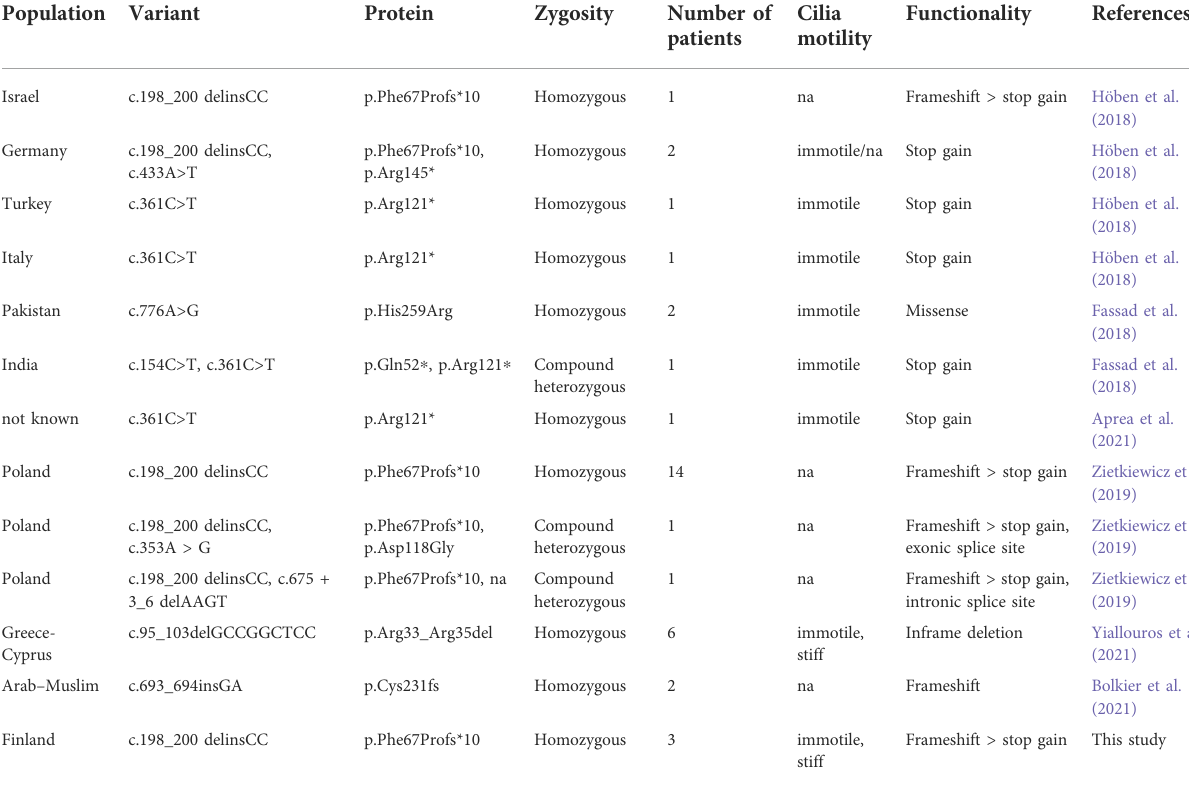
TABLE 2 CFAP300 mutations identi fi ed in PCD